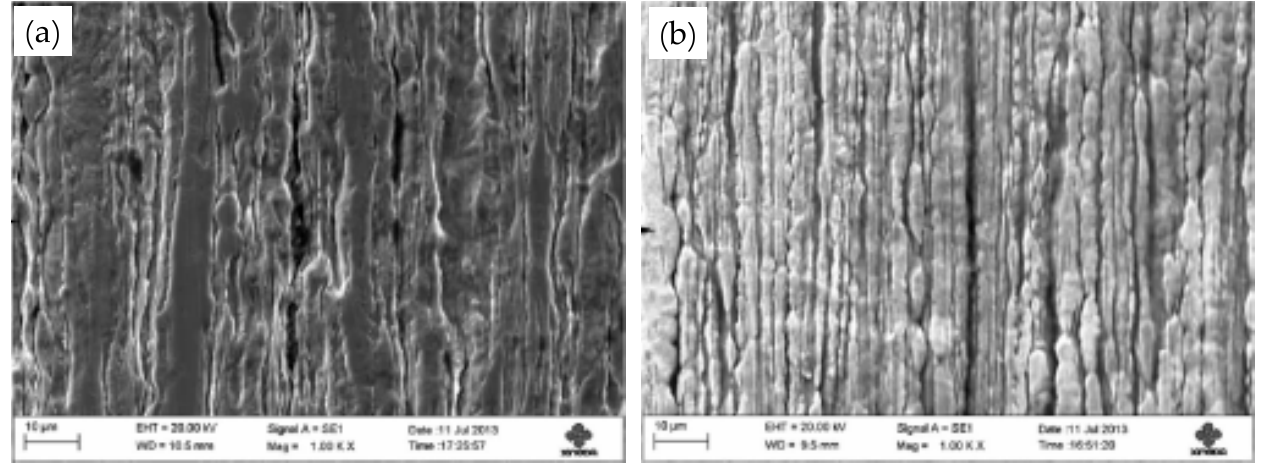
Figure 31. Surface roughness of the smooth medium-steel wire: ( a ) conventional process and ( b ) novel process. Reprinted with permission from ref. [71].